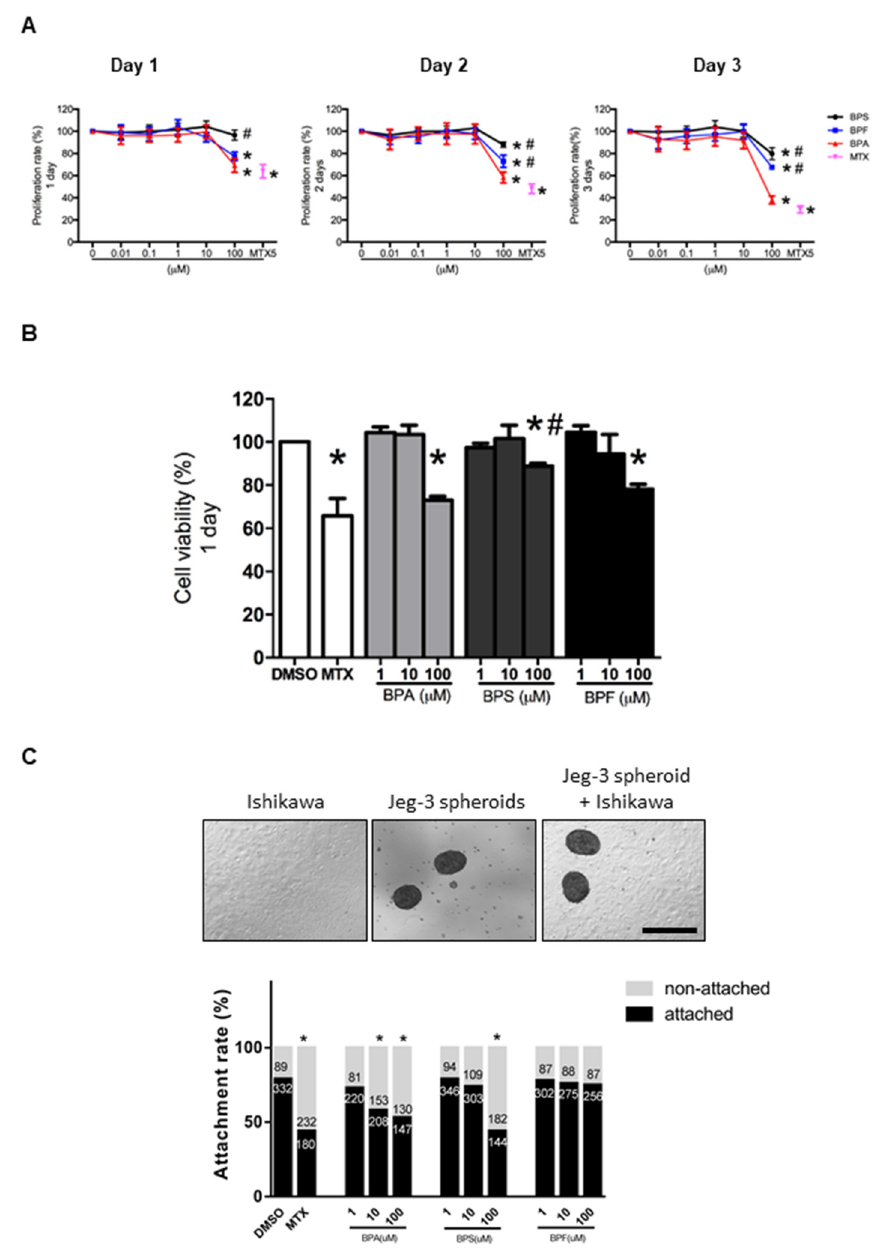
Figure 1. Effect of BPA, BPF, and BPS on Ishikawa cell proliferation, viability, and spheroid attachment. ( A ) The proliferation rate of Ishikawa cells treated with different concentrations of BPA, BPF, and BPS (0.01 to 100 μ M) on days 1, 2, and 3 ( n = 5). Methotrexate (MTX) at 5 μ M was used as the control in the proliferation assay. ( B ) Cell viability of Ishikawa cells treated with different concentrations of BPA, BPF, and BPS (1 to 100 μ M) on day 1 ( n = 3). ( C ) Photomicrographs showing Jeg-3 spheroids, Ishikawa cells, and attached spheroids on Ishikawa cells. The attachment rate of Jeg-3 spheroids on Ishikawa cells treated with different concentrations of BPA, BPF, and BPS (1 to 100 μ M) for 24 h prior. The number of attached spheroids over the total spheroids added is shown on the graph. * denotes p < 0.05 compared with DMSO control, and # denotes p < 0.05 compared with 100 μ M BPA.